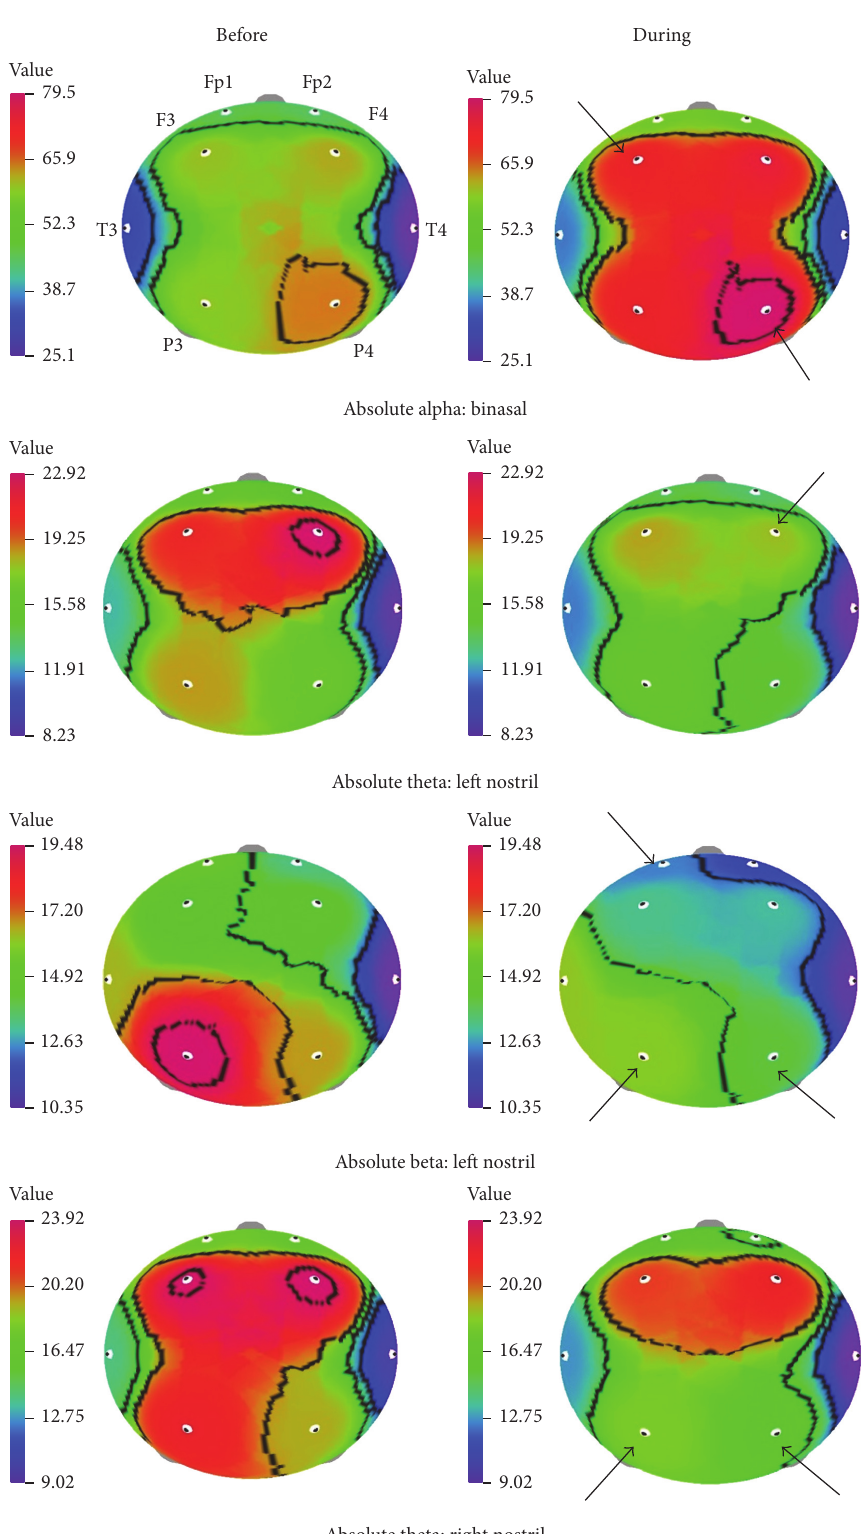
Figure 1: t -Mapping of EEG power spectrum changes before and during the binasal and uninasal inhalations of AEO. Fp1, left prefrontal; Fp2, right prefrontal; F3, left frontal; F4, right frontal; T3, left temporal; T4, right temporal; P3, left parietal; P4, right parietal. Arrows are showing significant changes in the regions during the inhalation of